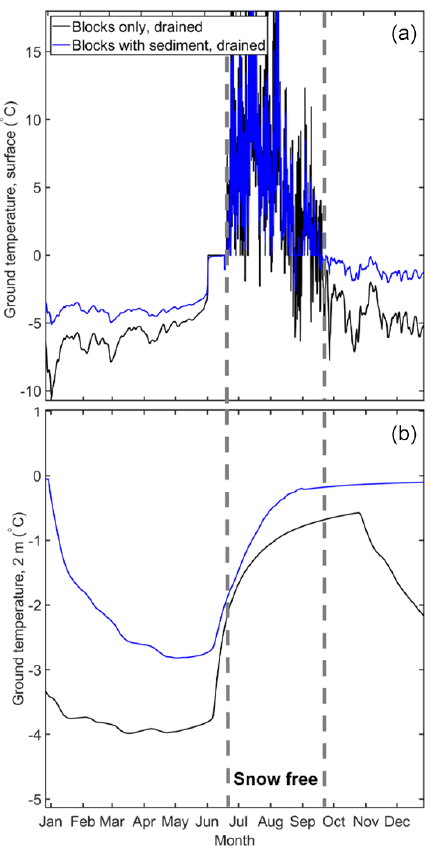
Figure 6. Modelled ground temperature at 0.05 (a) and 2m (b) depth for the blocks only, drained and blocks with sediment, drained scenarios during a year of an equilibrium run at Juvvasshøe for sf = 0 . 75. The snow-free summer season is highlighted. Note that the upper plot is truncated at 17 ◦ C, and maximum summer temper- atures are 26 ◦ C in both